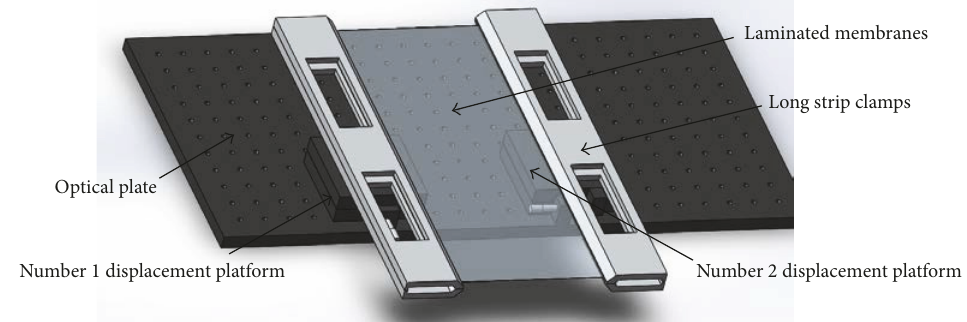
Figure 4: Clamping and loading devices.